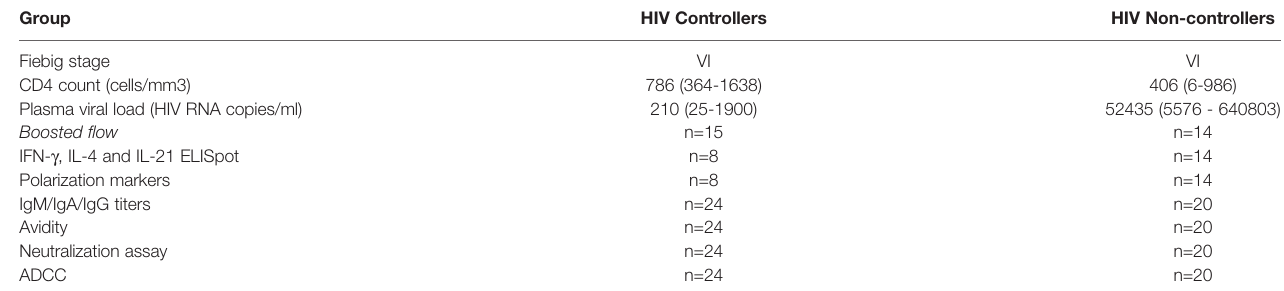
TABLE 1 | Clinical data (CD4 count and plasma viral load) and number of samples included in each experiment.